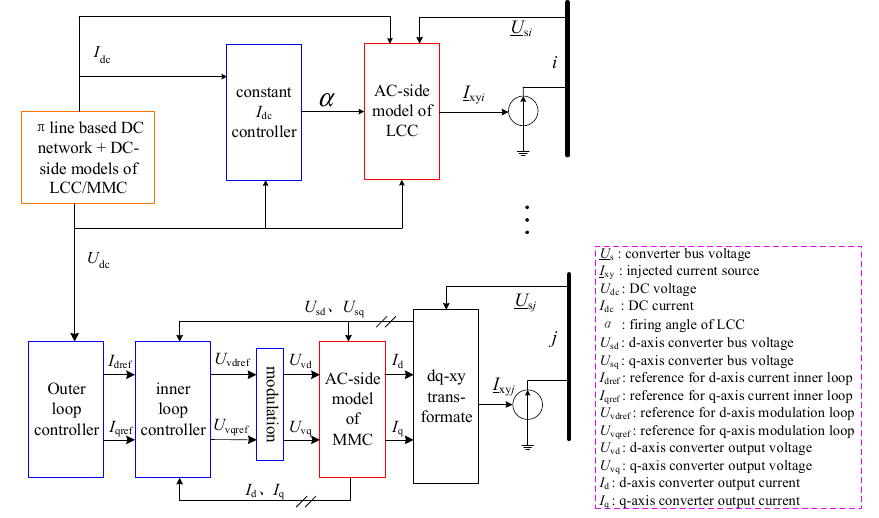
Figure 2. The whole structure of the electromechanical model of the LCC-MMC MTDC system.